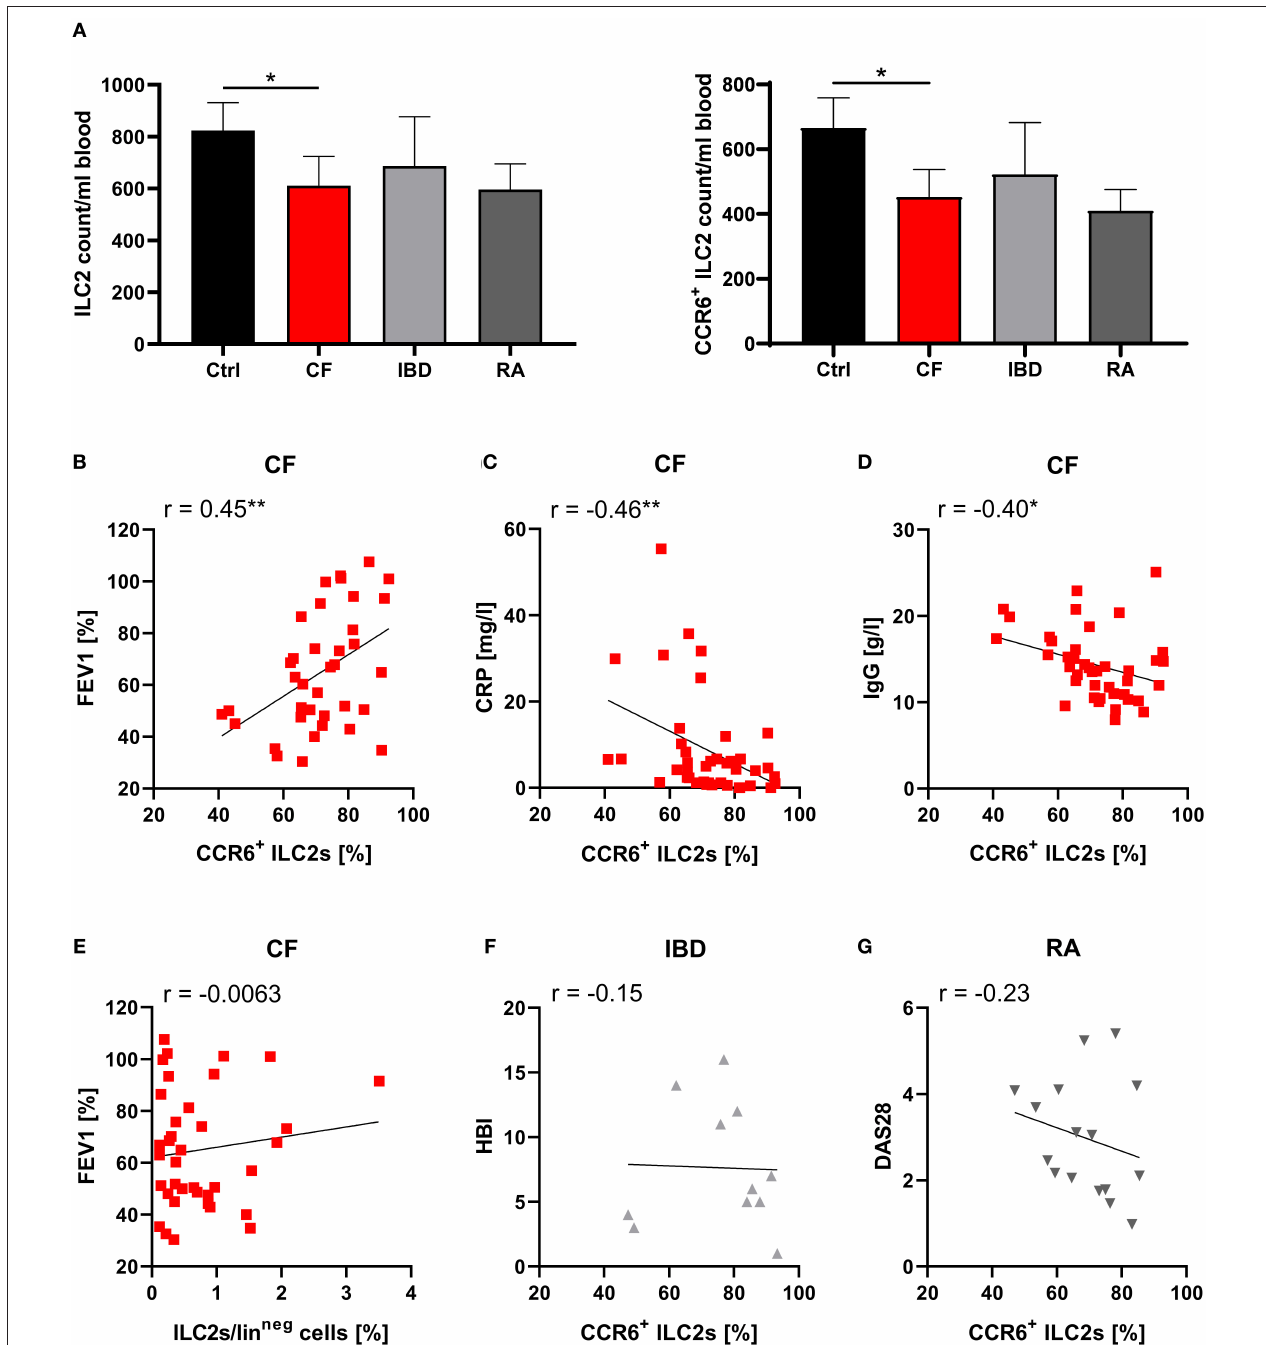
FIGURE 2 | Specific role of CCR6 + pb ILC2s on disease severity in CF patients. (A) Total counts of human pb ILC2s and CCR6 + ILC2s per ml blood donated by healthy controls (ctrl, n = 40–41) and patients with CF ( n = 35), IBD ( n = 12–13), or RA ( n = 17). Total counts were calculated based on PBMC numbers/ml blood (determined by Neubauer counting chamber) and the proportion of ILC2s and CCR6 + ILC2s among total PBMCs (determined by flow cytometry). The Mann–Whitney test was applied. (B–D) Correlation of the percentage of CCR6 + pb ILC2s and disease severity in CF patients based on FEV1% (B; n = 37), CRP (C; n = 41) and IgG serum levels (D; n = 41). The included raw data on CCR6 expressing pb ILC2s were partly also used in Figure 1D . (E) Correlation of the pb ILC2 frequency and FEV1% in CF patients ( n = 37). (F,G) Correlation of the frequency of CCR6 + pb ILC2s and disease severity in Crohn’s disease patients (F; Harvey-Bradshaw Index - HBI; n = 11) and RA patients (G; Disease Activity Score 28 - DAS28; n = 16). Spearman’s r and regression lines are indicated. * p < 0.05,** p < 0.01.